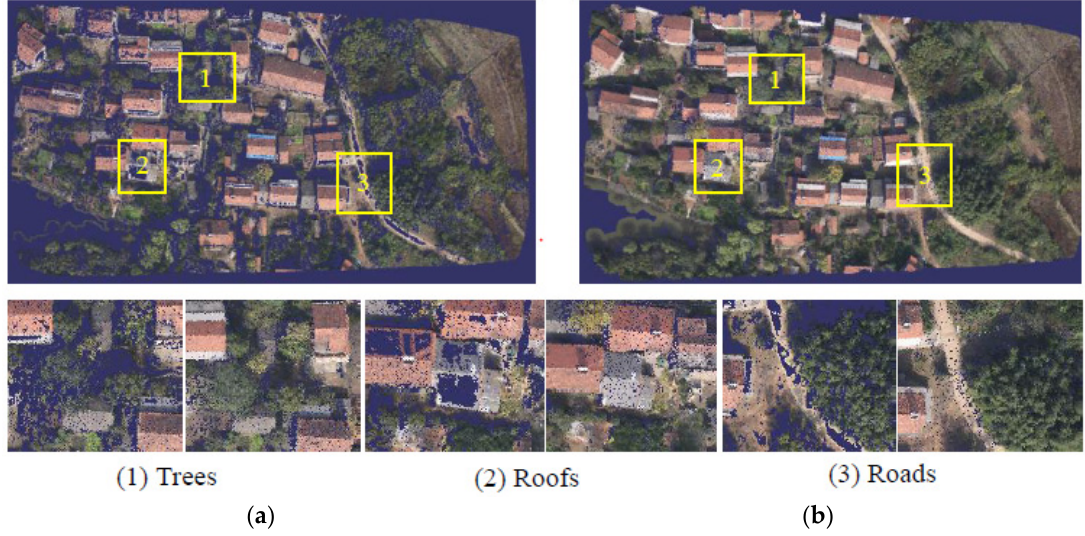
Figure 5. Comparation of point cloud with/without using the semi patch dense match. ( a ) Match result without using semi patch ( b ) Match result using semi patch.